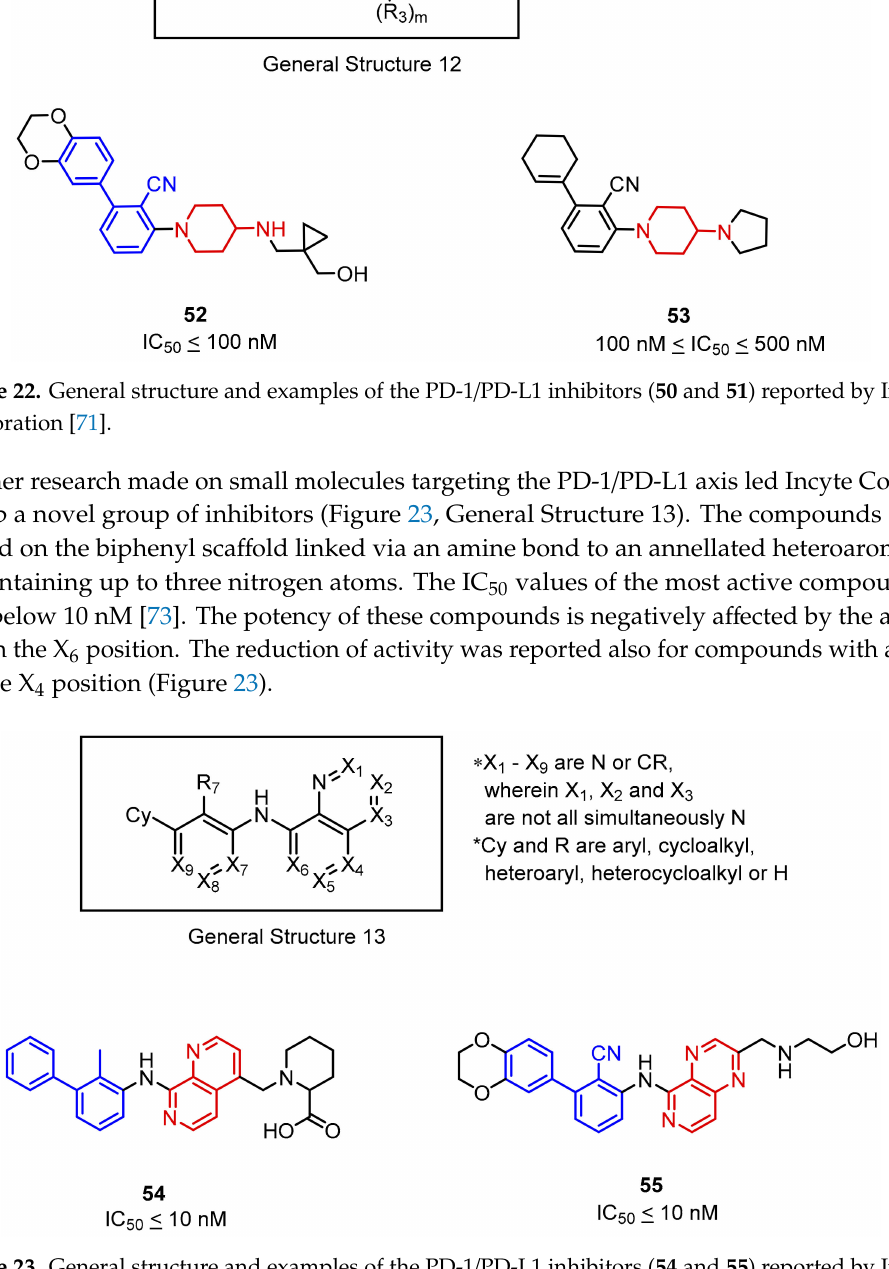
Figure 23. General structure and examples of the PD-1 / PD-L1 inhibitors ( 54 and 55 ) reported by Incyte Corporation, based on the fused six-membered heteroaromatic rings linked with the biphenyl sca ff